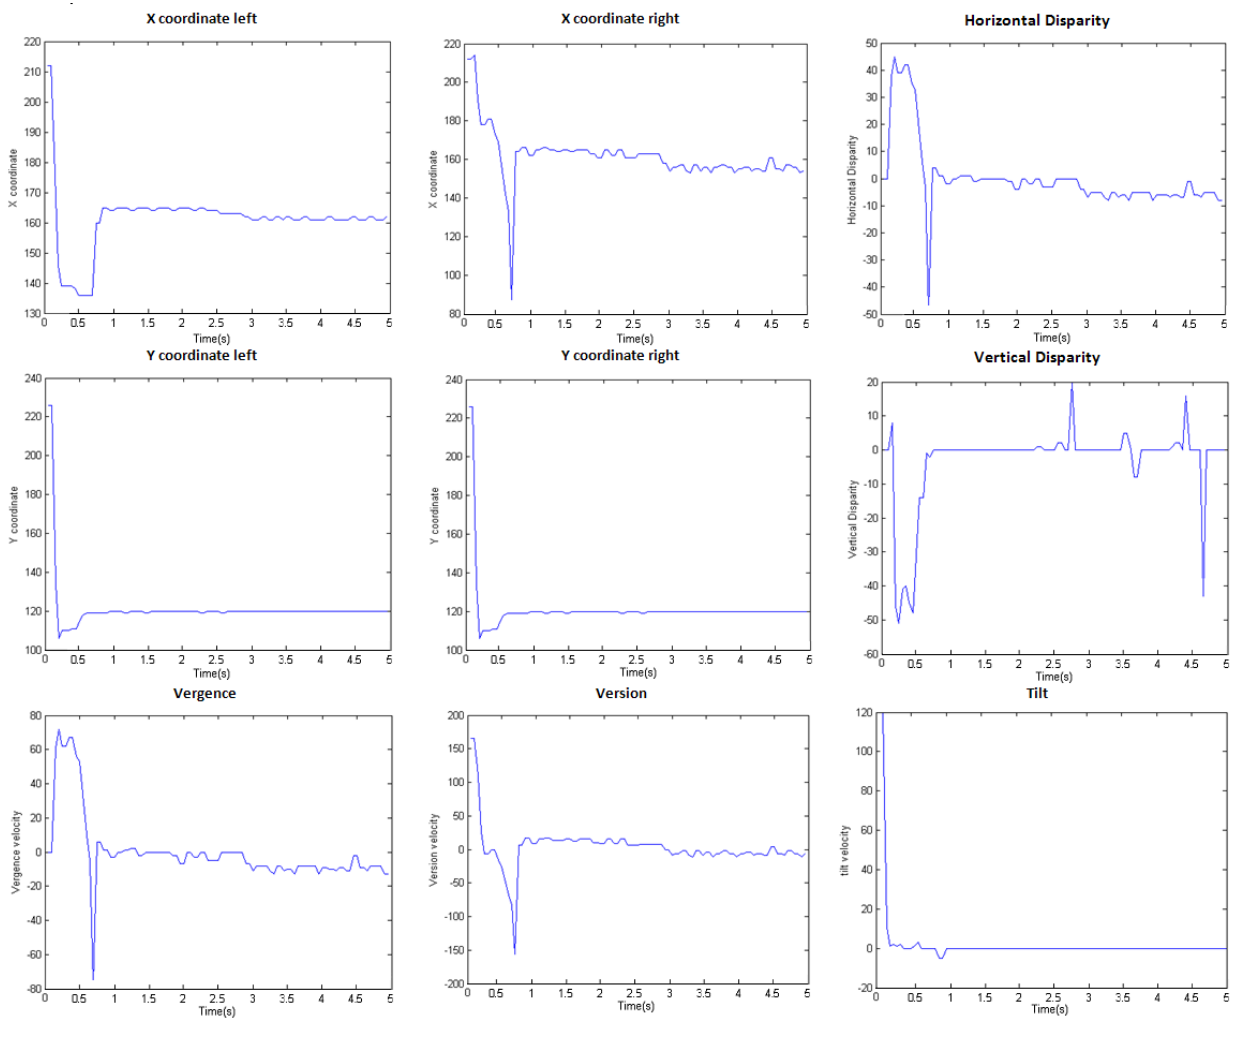
Figure 12. Red plastic bottle fixation example: X and Y coordinates for left and right images, horizontal and vertical component disparities and the evolution of version, vergence, and tilt velocities along the time (image resolution is 320 ×